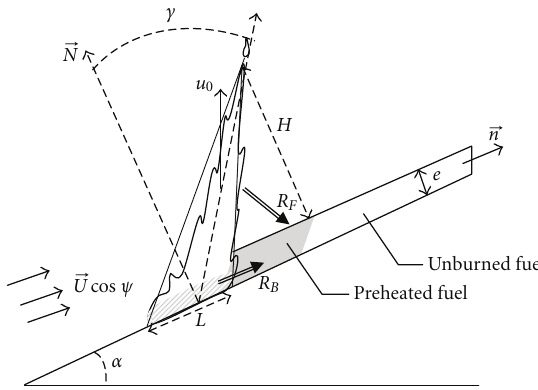
Figure 1: Flame profile along the normal direction to the fire